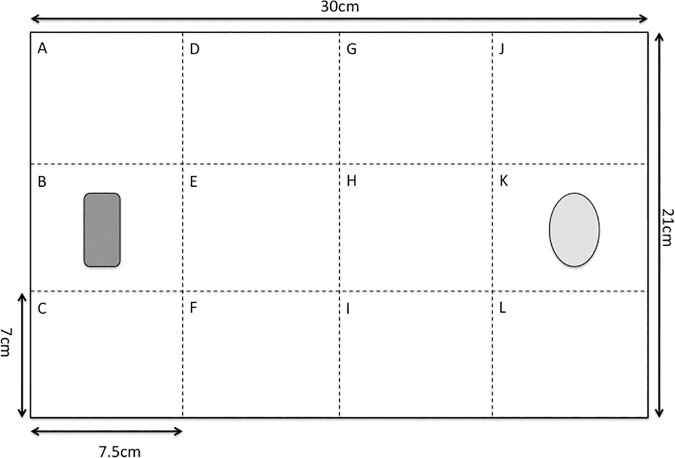
Diagram of testing arena.This illustrates the arena used in the exploration trial during behavioural testing in Diploptera punctata. A piece of A4 paper lined the bottom of the arena to mark the borders of sectors A to L; this was replaced for each new individual tested. Vaseline was applied to the sides of the arena above the paper to prevent cockroaches from climbing up the sides; the depth of the arena was approximately 8cm. The focal individual was introduced to the arena via an opaque tube placed in sector B. Sector K contained an empty plastic dish.